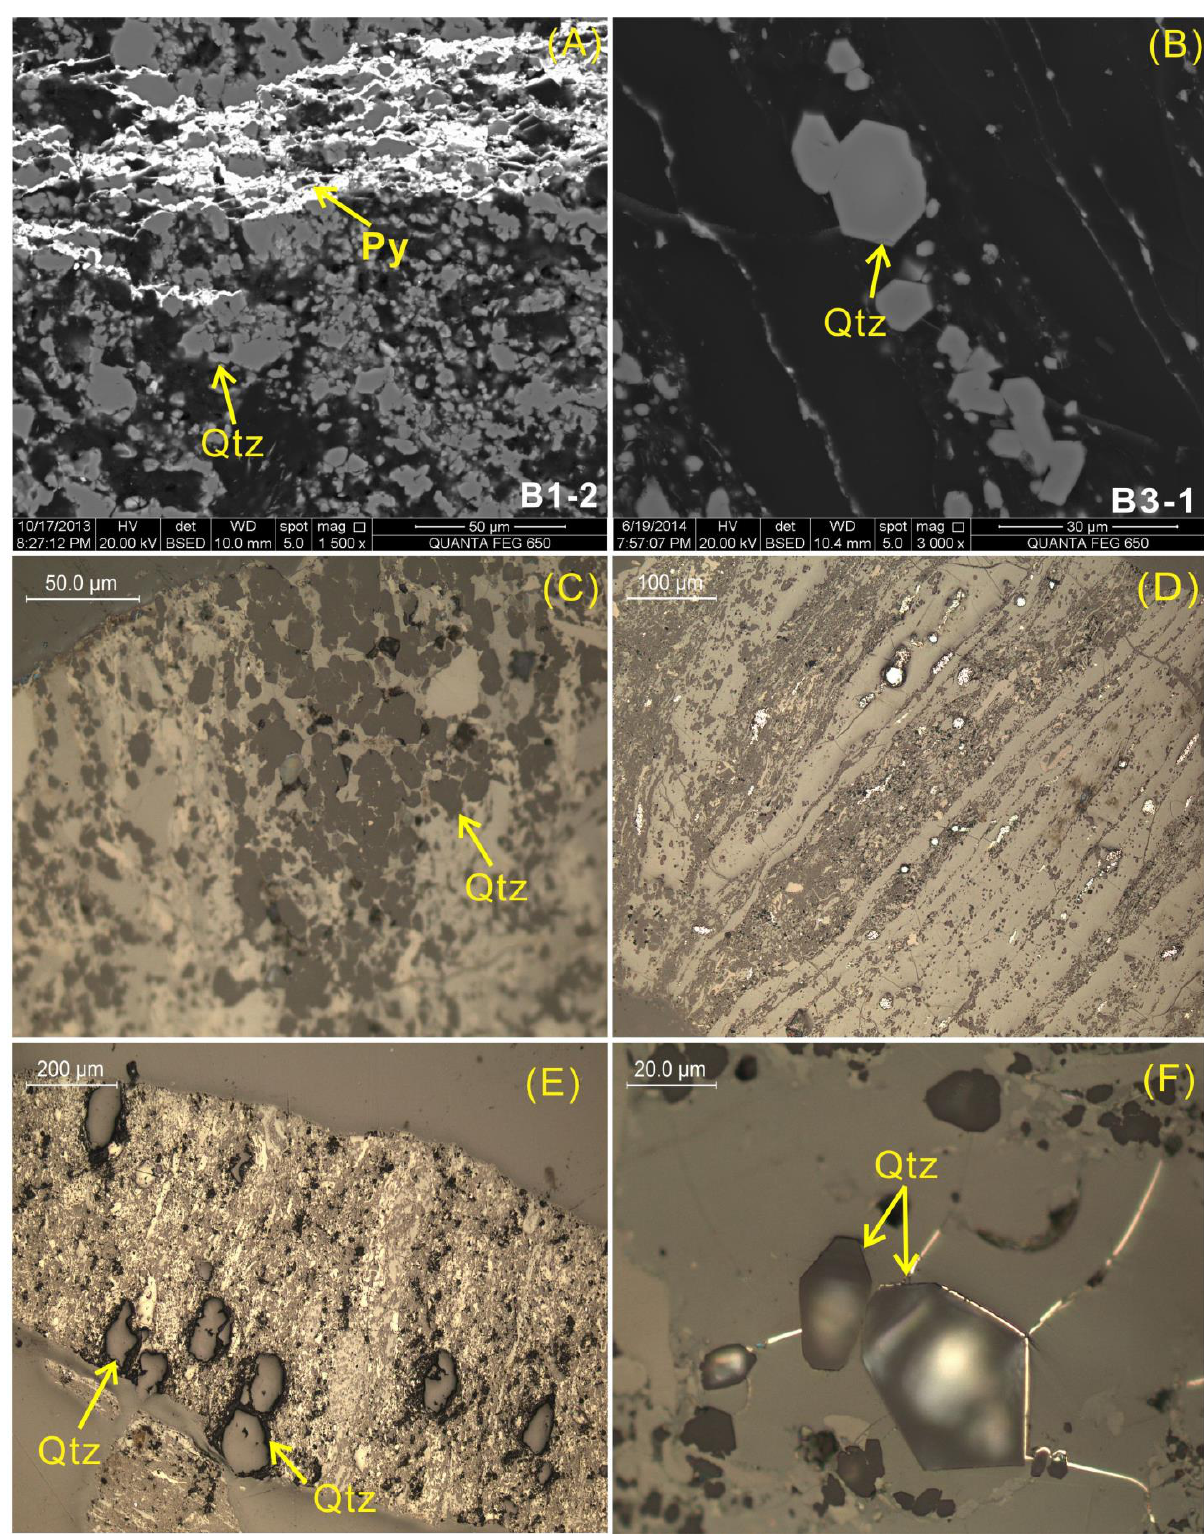
Figure 8. Quartz in the coal samples. ( A ) Authigenic quartz and fracture-filling pyrite in sample B1-2. ( B , C ) Fine-grained quartz in collodetrinite in sample B3-1. ( D ) Small quartz particles and framboidal pyrite along the lamination planes in sample B1-1 . ( E ) Detrital quartz in sample B2-1. ( F ) Hexagonal bipyramid quartz rimmed by epigenetic pyrite in sample B3-1. ( A , B ), Back-scattered electron images. ( C – F ), Optical microscope, reflected light in air. Qtz: quartz. Py: